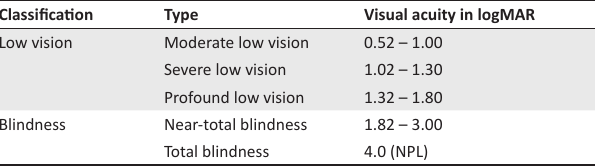
Table 1: WHO classification of low vision and blindness according to VA 8